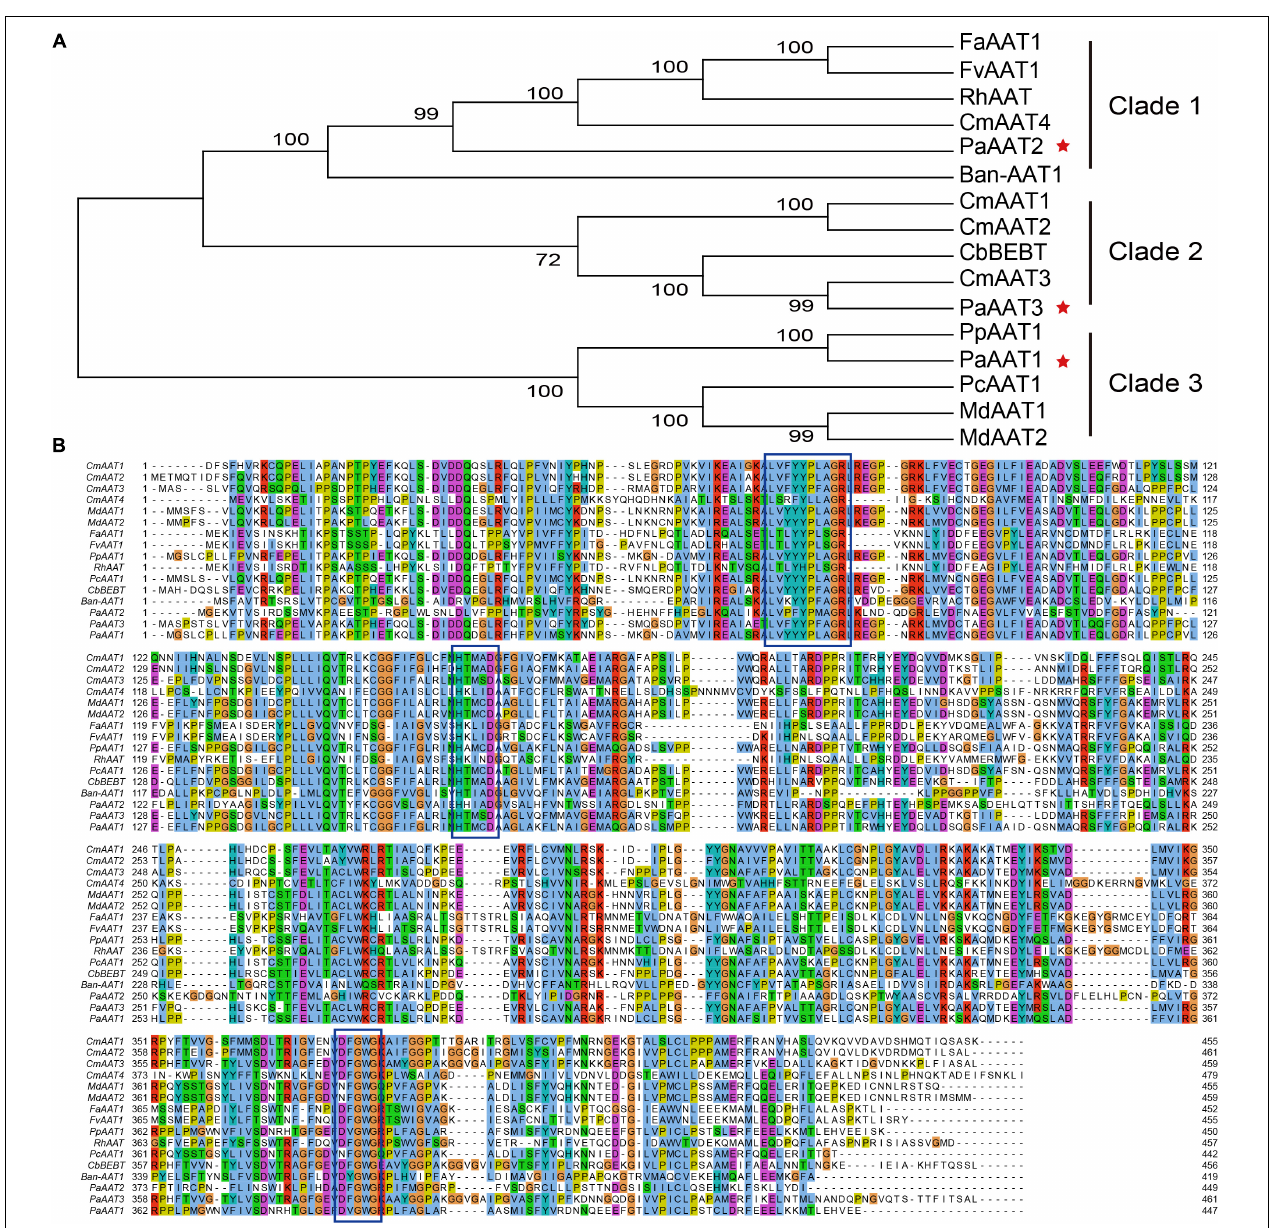
FIGURE 2 | Phylogenetic analysis of the PaAAT protein and other representative alcohol acyltransferases. (A) Phylogenetic tree of AAT proteins. The tree is drawn to scale, with branch lengths measured by the number of substitutions per site. The percentage bootstrap values (1,000 replicates) for groupings are given for each branch. (B) Sequence comparison of AAT proteins. Supplementary Table 1 presents the GenBank accession numbers of each AAT sequence used. The five-pointed stars in (A) are the apricot AATs. The conserved motifs are framed in (B) .